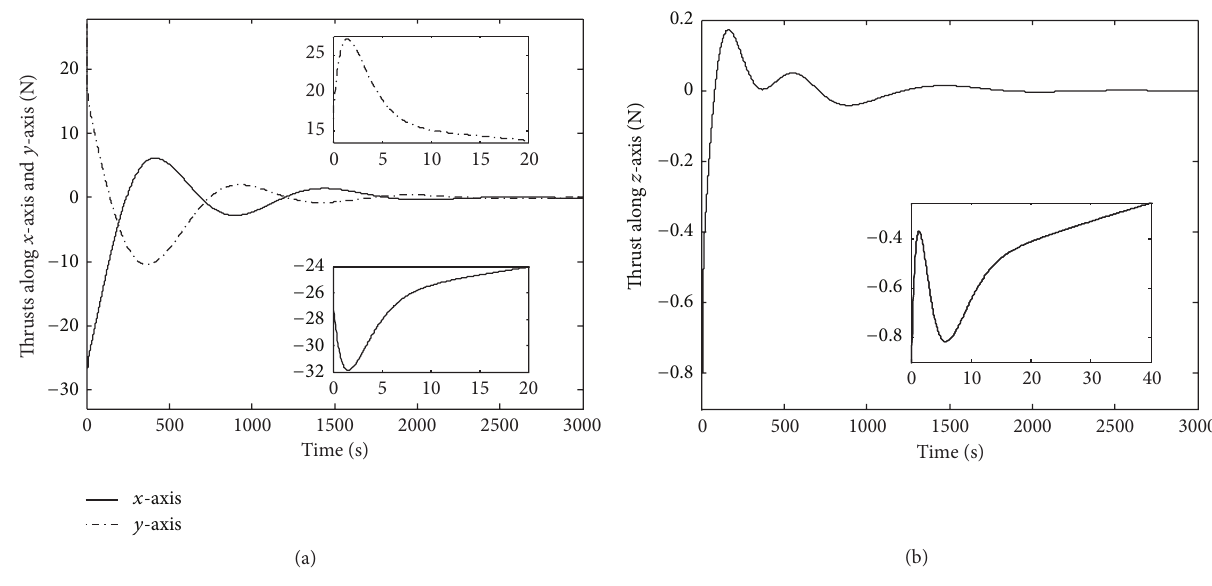
Figure 4: Propulsive thrusts of the chase vehicle along each